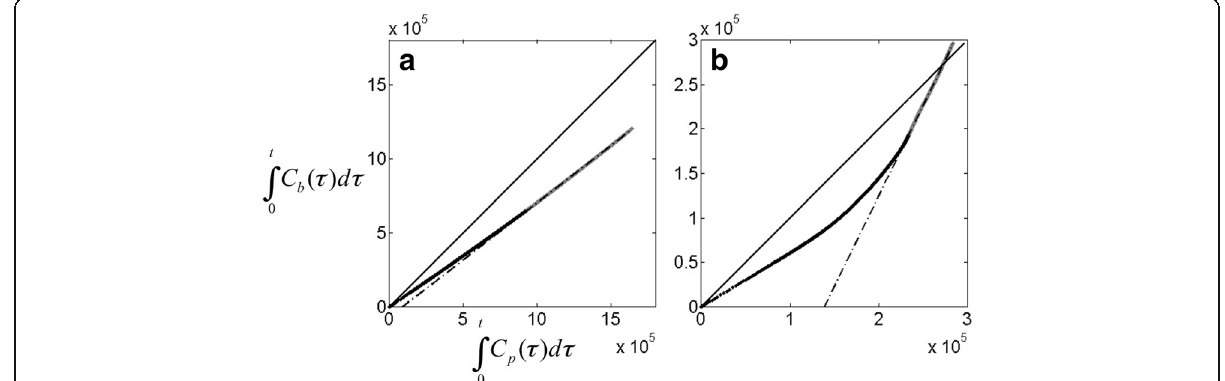
Fig. 2 Integrals of whole blood radioactivity plotted against the integral of the metabolite corrected input functions for [ 11 C]raclopride ( a ) and [ 18 F]MNI-659 ( b ). For t > t* , the plot becomes linear (gray line), allowing for estimation of α in Eq. (6)